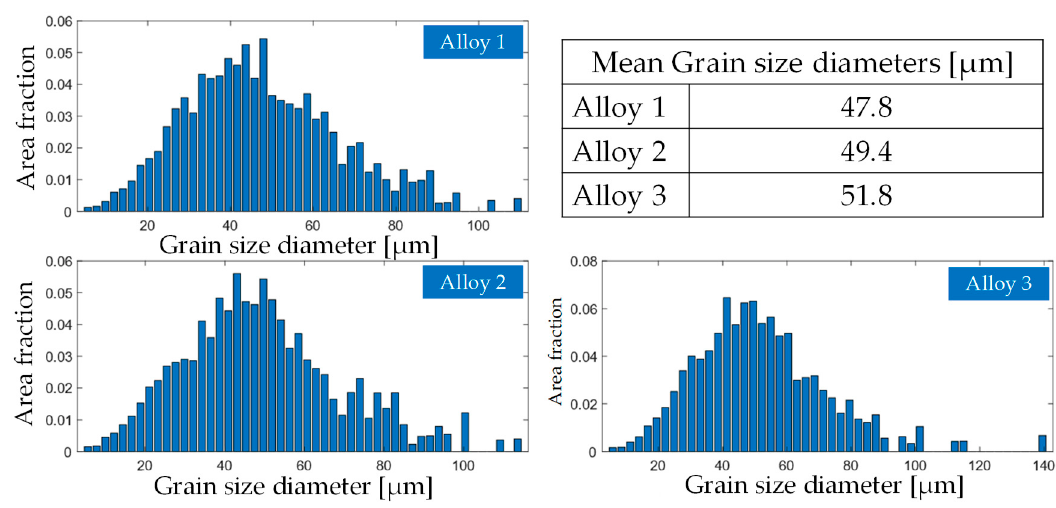
Figure 8. Grain size distribution of alloys A1–A3.